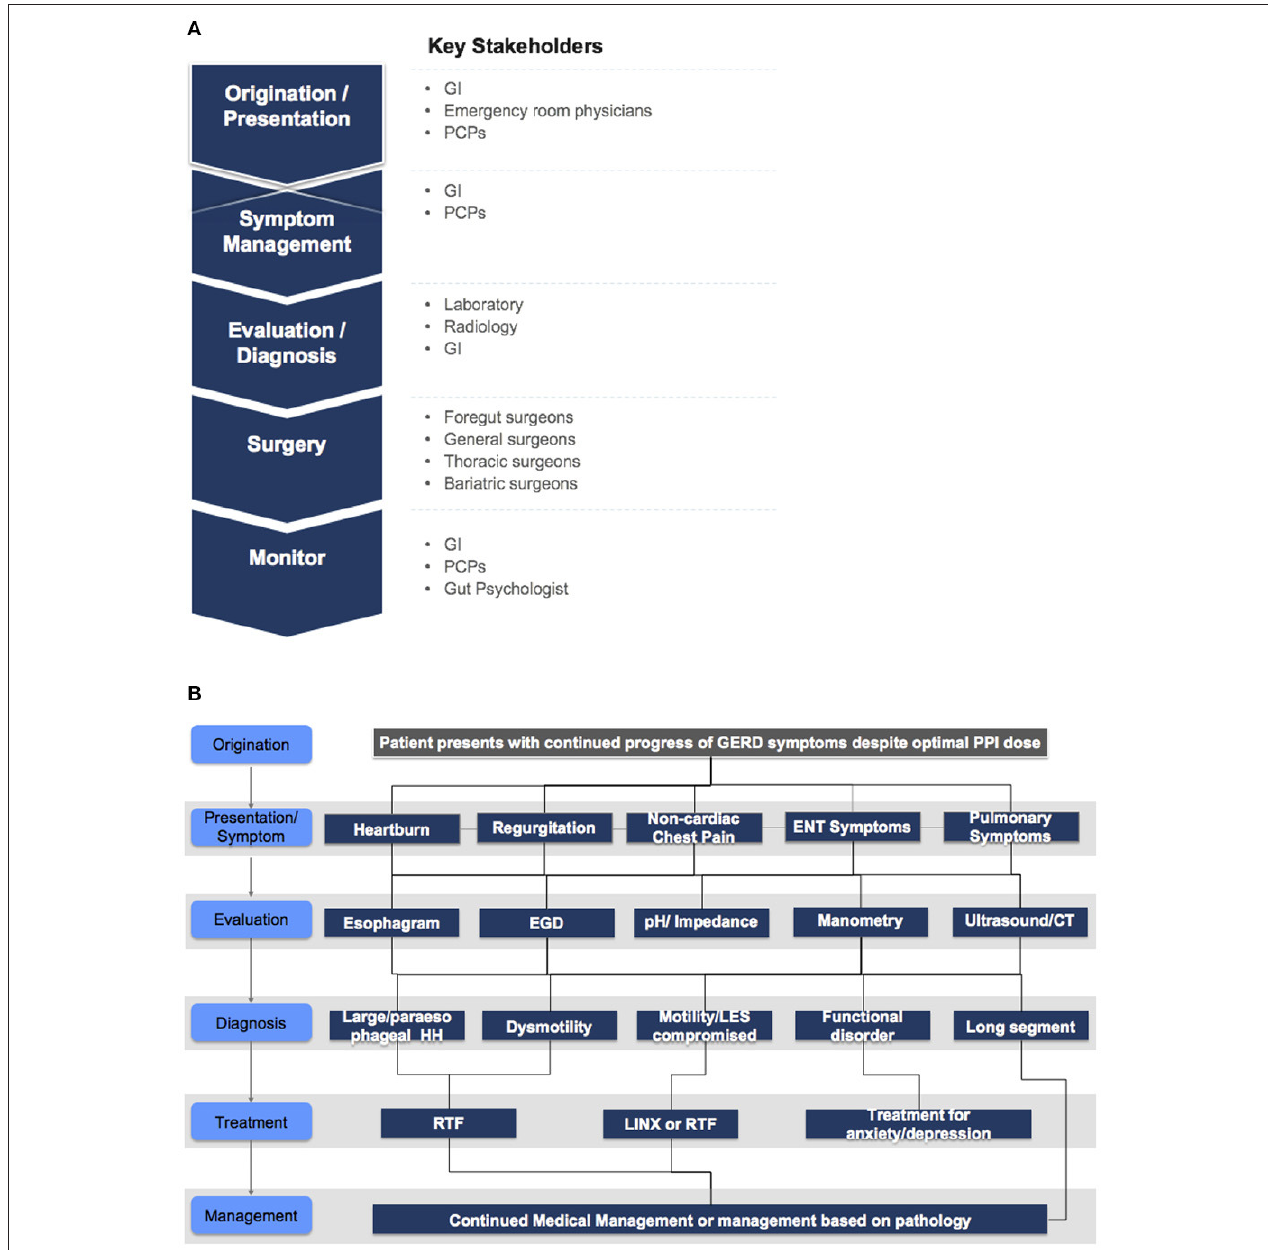
FIGURE 3 | (A) Patient flow and associated providers. (B) Treatment decision tree implemented at our heartburn center.